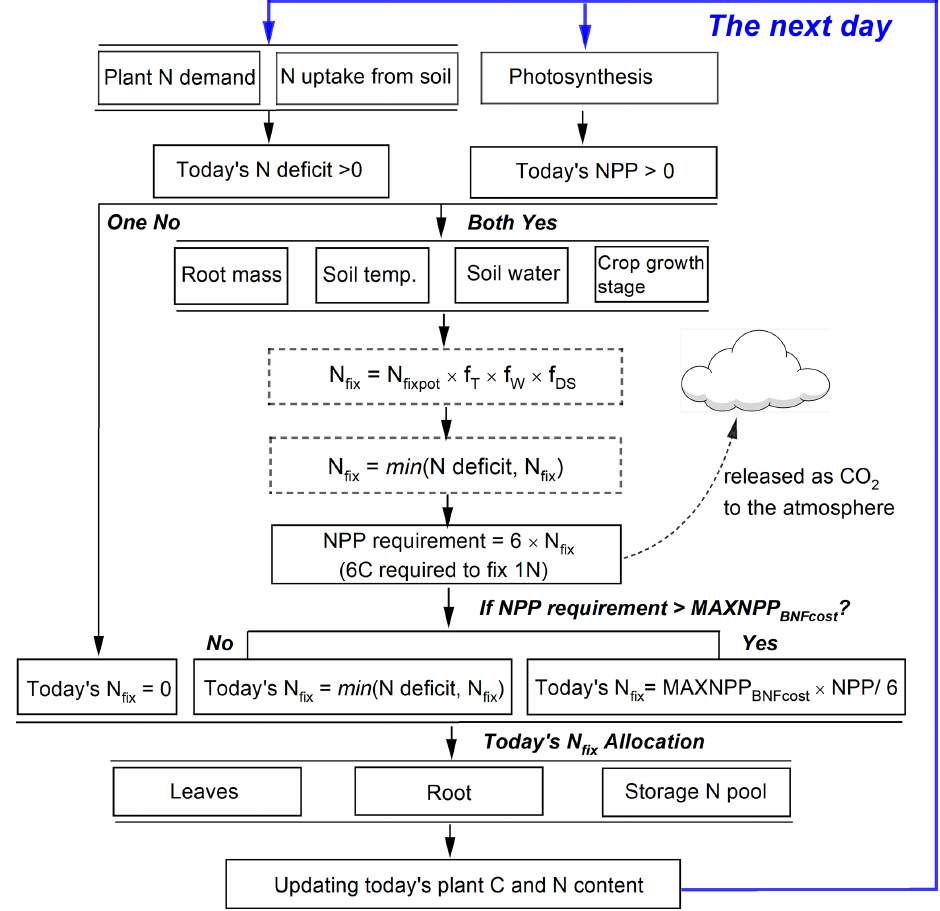
Figure 2. Representation of the N fixation route used in grain legumes in LPJ-GUESS. Today’s N deficit is calculated as the difference between plant N demand and soil mineral N uptake. N fix in dotted boxes represents intermediate